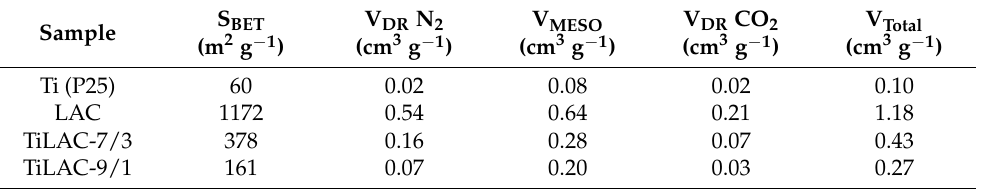
Table 1. Textural parameters for P25 TiO 2 , the prepared luffa activated carbon (LAC) and TiLAC